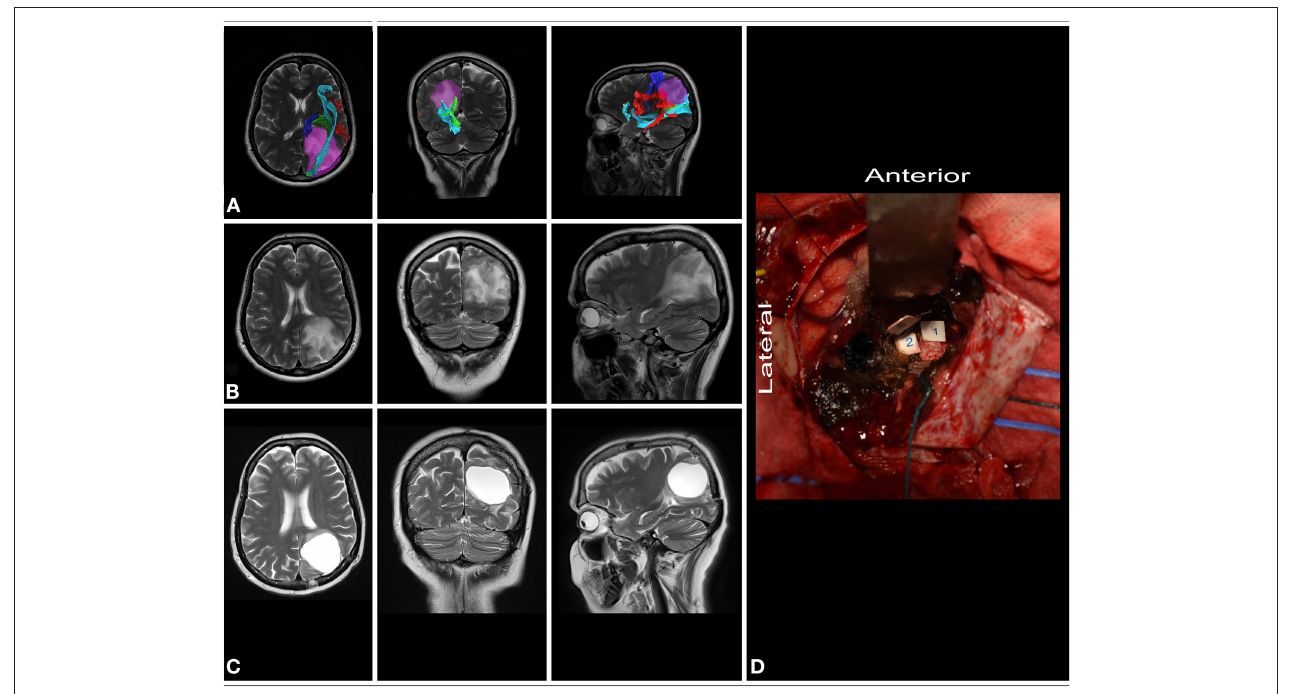
FIGURE 7 | 51-year-old right-handed women with a low-grade glioma within dominant parietal lobe. (A) axial, coronal, and sagittal MRIs with diffusion tensor imaging tractography reconstruction of the tracts passing within the parietal lobe. The tumor (purple) is medial to the AF/SLF complex (red), optic radiation (green) and IFOF (light blue), while posterior to the corticospinal tract (blue). (B,C) axial, coronal, and sagittal MRIs with preoperative and postoperative imaging. (D) Intraoperative photograph taken after tumor resection within functional borders, depth of resection is marked with corticospinal tract (tag 1), AF/SLF complex (tag 3) and the SS (tag 2). Patient was operated on in the semi-sitting position. DTI were reconstructed in DSI Studio (http://dsi-studio.labsolver.org) (